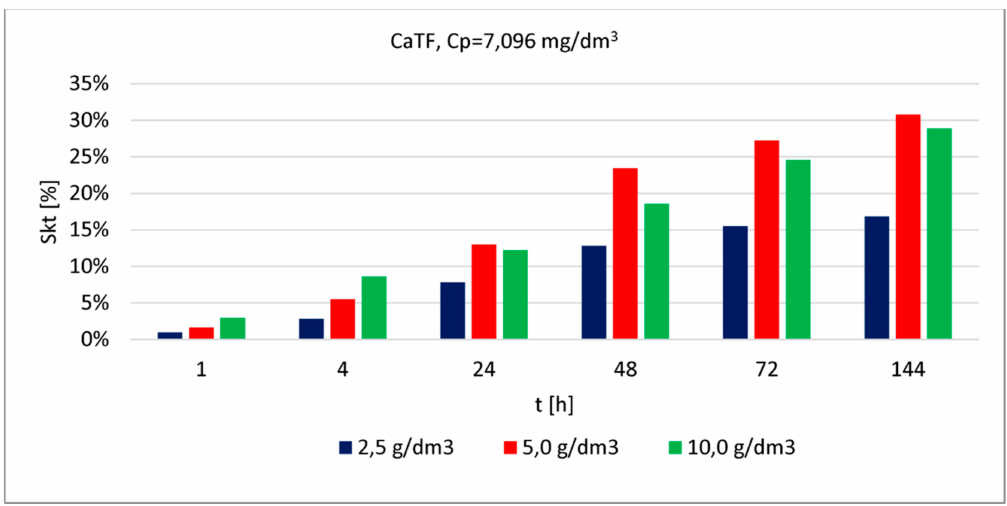
Figure 6. Phosphate removal e ffi cacy (7.096 [mg / dm 3 ]) by CaTF (dose: 2.5; 5.0; 10.0 [g / dm 3 ]) at di ff erent contact time